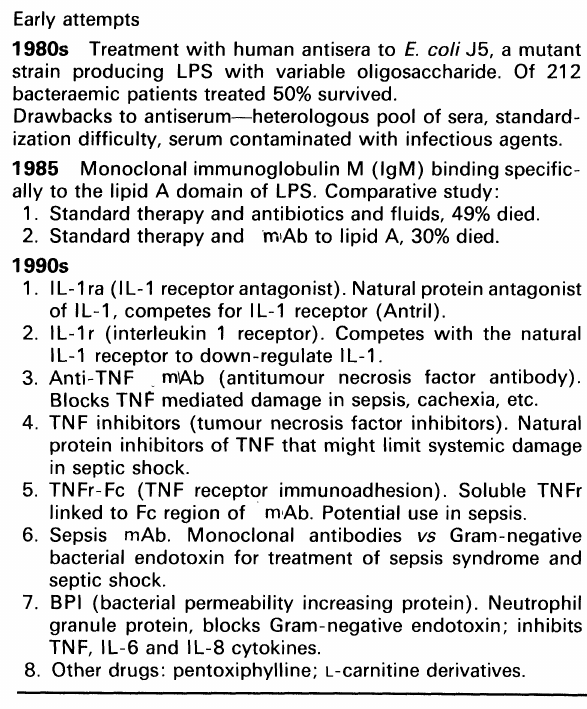
Table 17. Potential treatments for septic shock Early attempts 1980s Treatment with human antisera to E. coli J5, a mutant strain producing LPS with variable oligosaccharide. Of 212 bacteraemic patients treated 50% survived. Drawbacks to antiserum--heterologous pool of sera, standard- ization difficulty, serum contaminated with infectious agents.